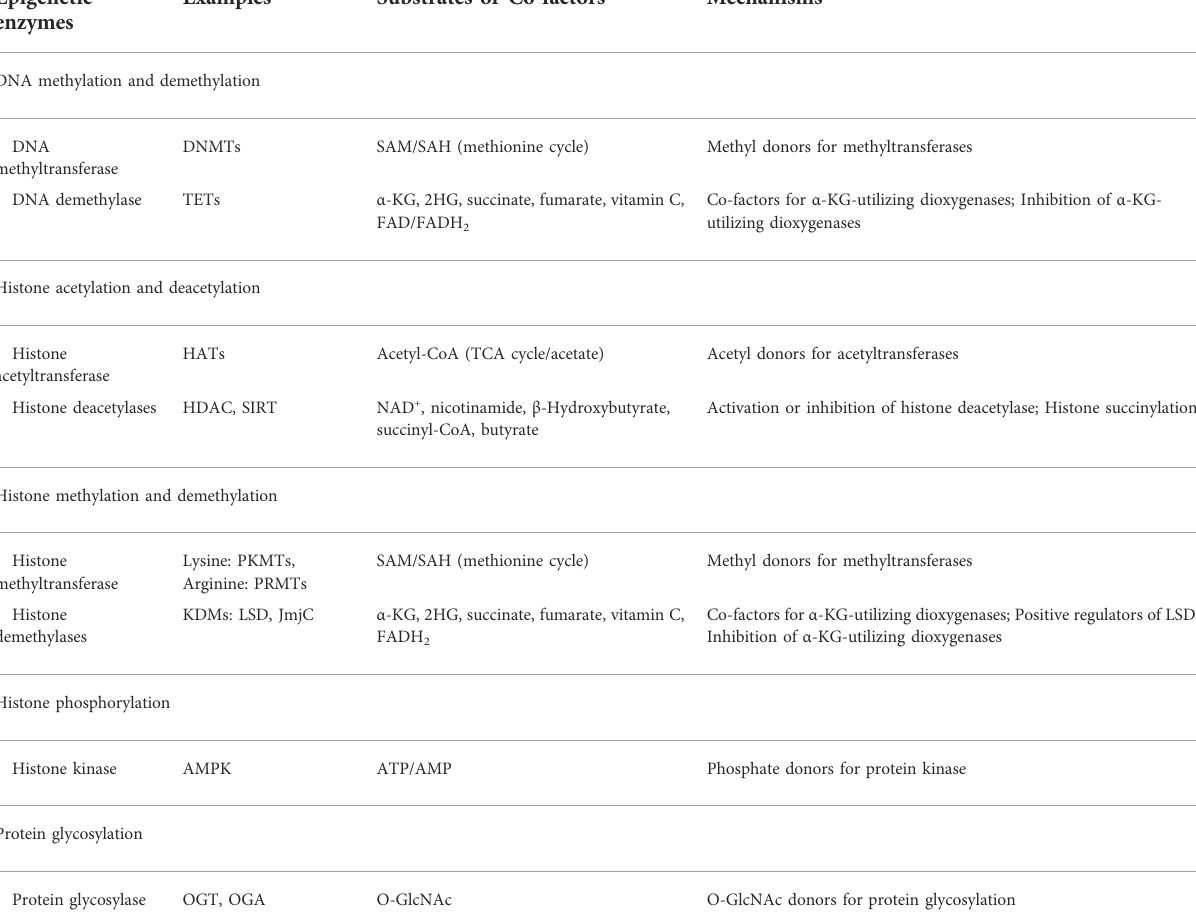
TABLE 2 Metabolites are either substrates or co-factors for epigenetic enzymes in cancer